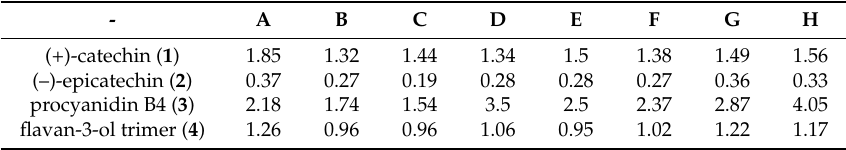
Table 3. Amount of each flavan-3-ol derivative (mg/g DW) in raspberry leaves. - A